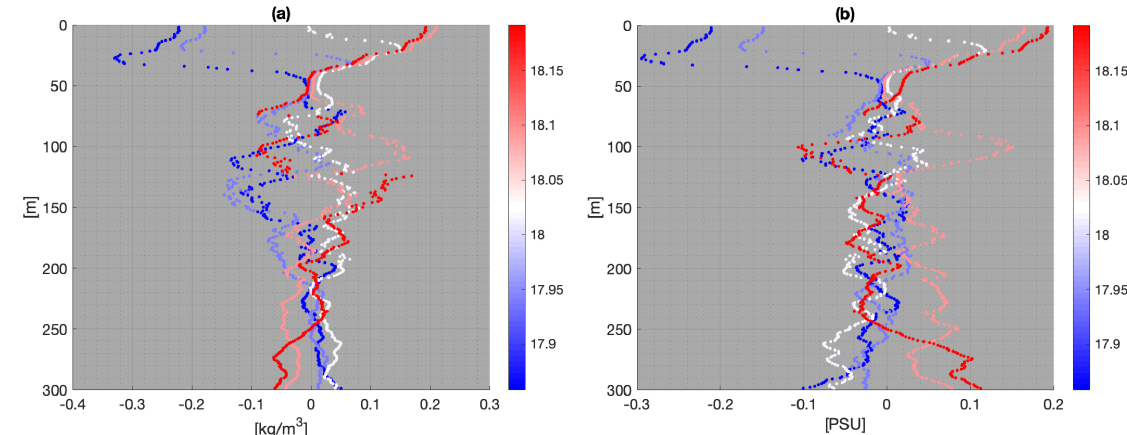
Figure 5. ( a ) Difference from mean density profile of North–South transect stations, and ( b ) Difference from mean salinity profile of North–South transect